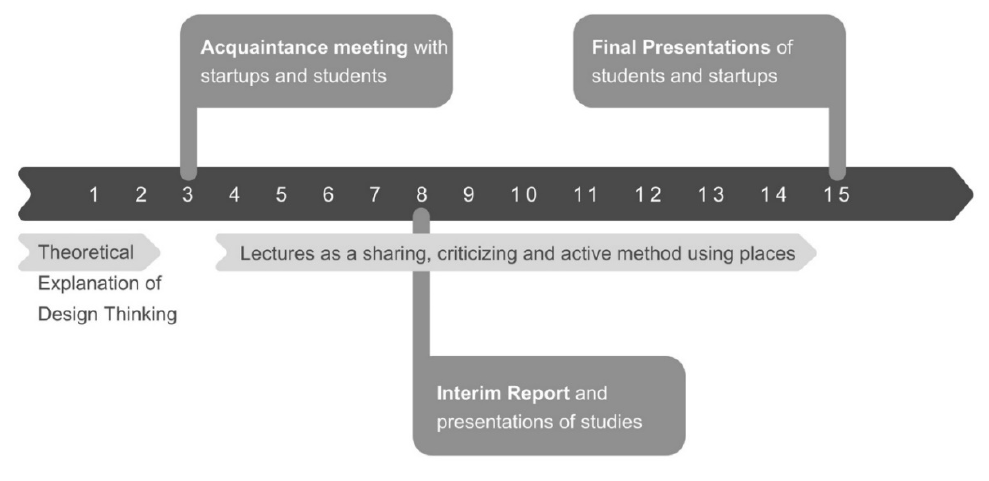
Figure 1: Weekly summary of